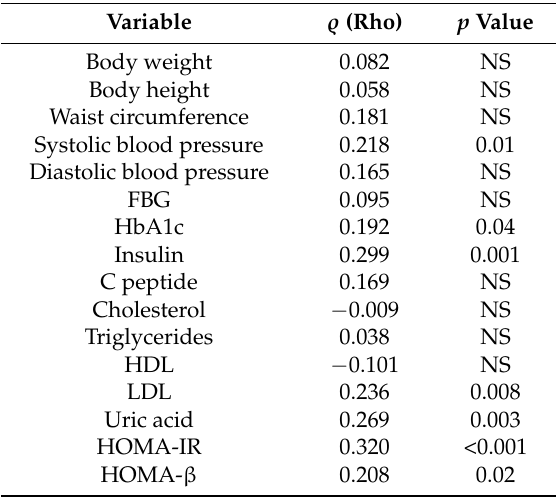
Table 2. Correlation of disease severity and components of metabolic